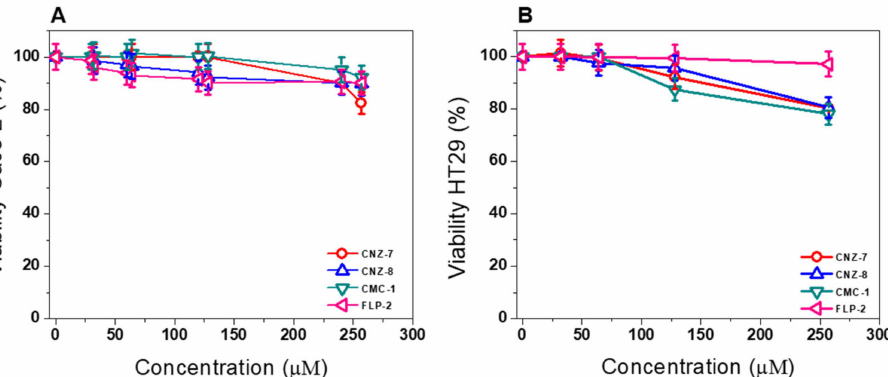
Figure 10. Cytotoxic effect of compounds on Caco-2 and HT29 cells via concentration–response curves for cell viability of ( A ) Caco-2 cells and ( B ) HT29 cells treated with CNZ-7, CNZ-8, FLP-2, and CMC-1. An XTT cell proliferation assay determined the viability. The values represent the mean ± standard deviation from three independent experiments, with standard errors lower than